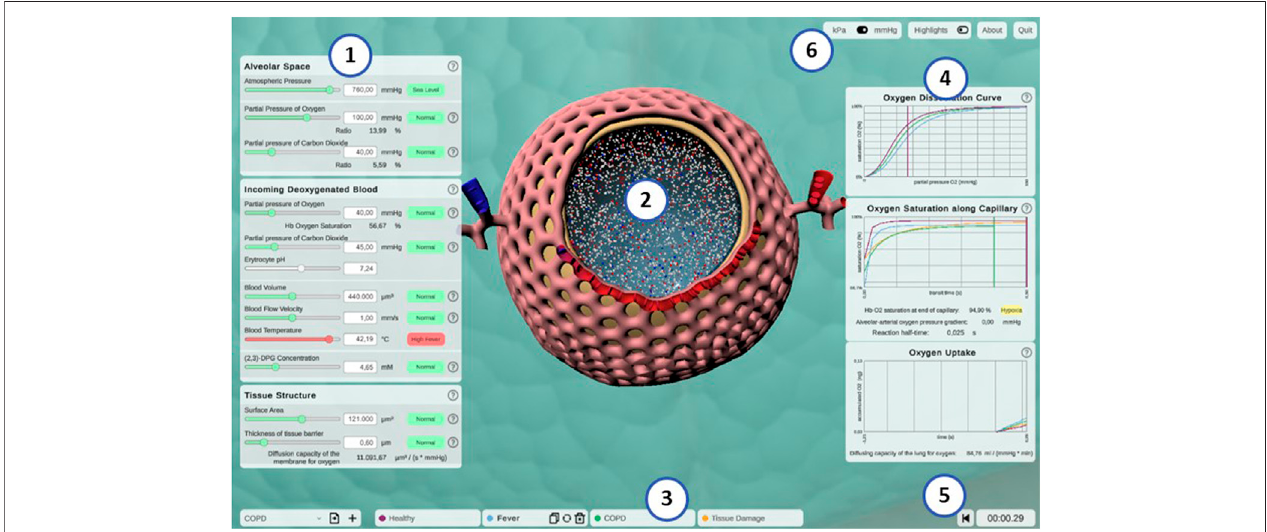
FIGURE 4 | Screenshot of the interactive application Alvin . (1) Model parameters are grouped in categories and can be con fi gured by the user. Colors and information text provide possible real-world interpretation of the values. (2) Animated simulation of an alveolus for the active parameter set provides visualization of the effect of the model parameter values. (3) To increase exploratory value, multiple simulation instances can be compared. (4) Quantitative simulation output is displayed with plots color-coded for each active instance of the simulation. (5) Simulation time is displayed and can be reset. (6) Utility functions and settings are available.